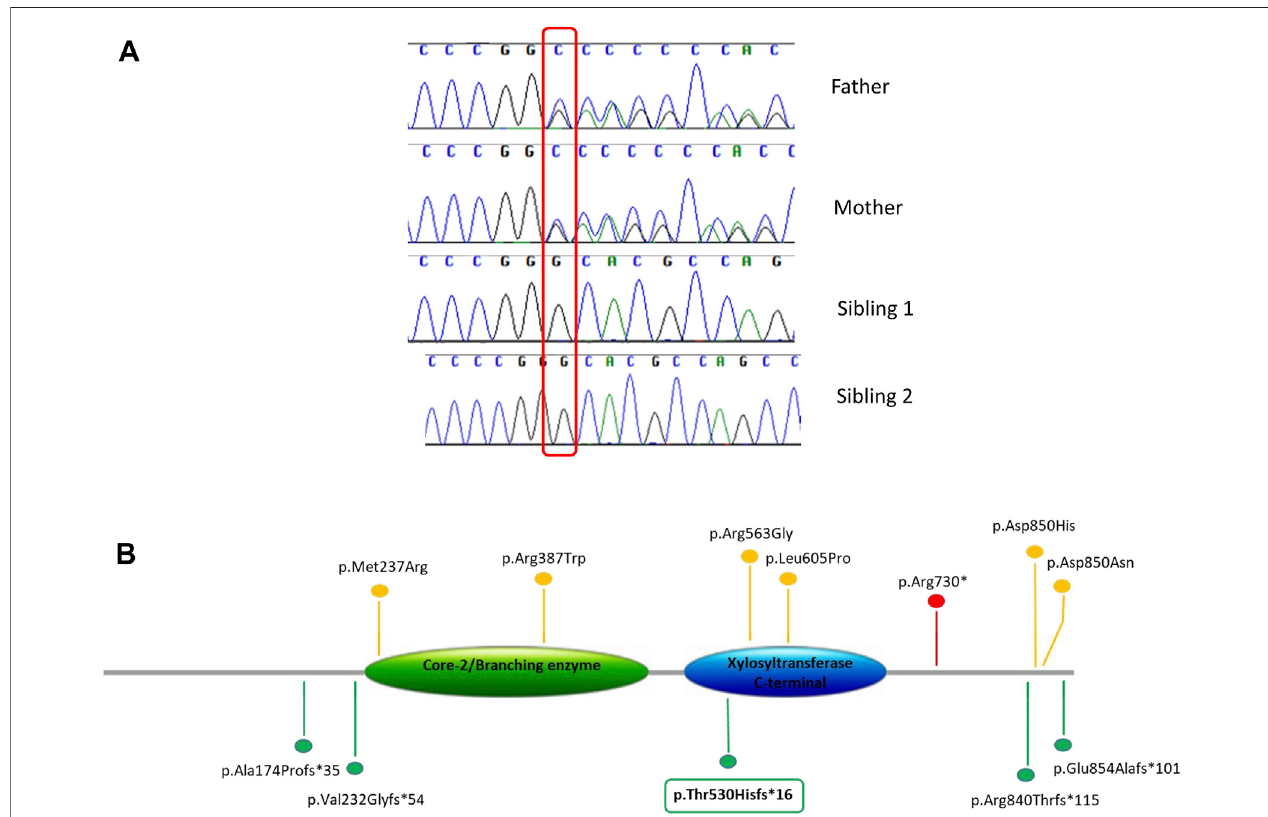
FIGURE 3 | (A) Variant con fi rmation and segregation analysis by Sanger sequencing. (B) Schematic view of the XYLT2 protein (NM_022167), showing previously reported variants and the novel variant identi fi ed in this study (in box). Different types of variants are labeled with different